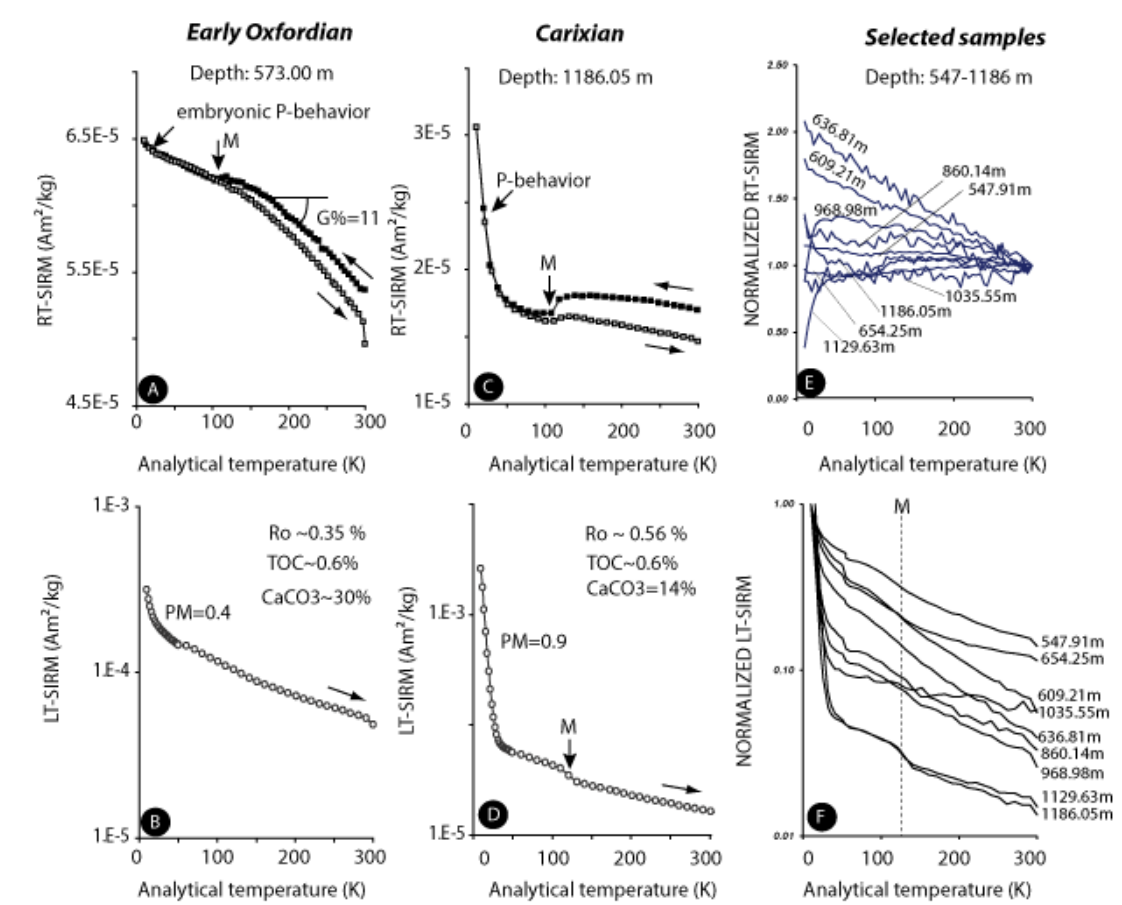
Figure 6. Cooling ( A , C , E ) and warming ( B , D , F ) monitoring of artificial remanence acquired at room temperature (RT-SIRM) and 10 K (LT-SIRM), respectively. All data are from Borehole EST433. Some data were published in Blaise et al. [19]. Early Oxfordian shales ( A , B ) displayed characteristics of immature rocks in the sense of organic matter maturity. The Carixian sample ( C , D ) displayed characteristics of early mature rocks. Selected samples taken at different depths ( E , F ); note the gradual increase of PM with depth ( F ). M is the Verwey transition at ~120 K, and was indicative of stoichiometric magnetite. The P-behavior and PM were indicative of fine magnetic particles in the superparamagnetic state.